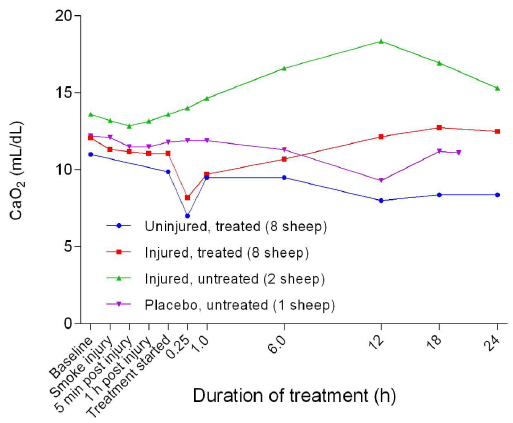
Figure 36. Arterial oxygen content (Mean ± SD error bars not shown) in smoke and non-smoke injured sheep that received extracorporeal life support as compared to that in untreated controls.